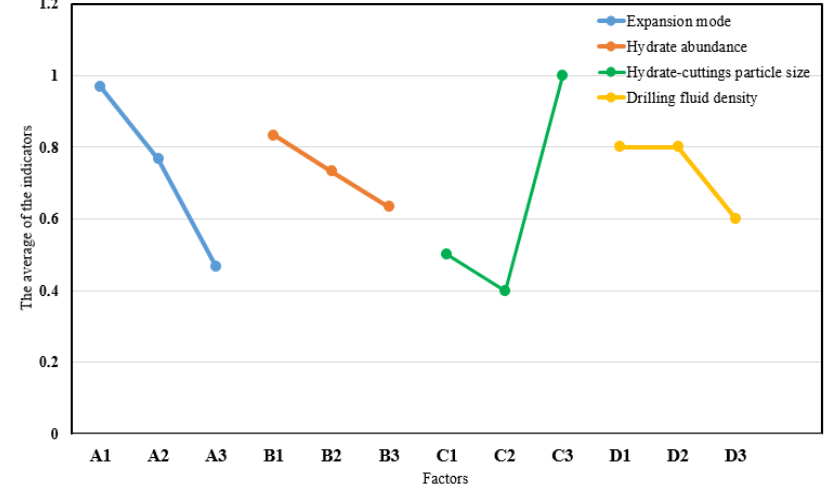
Figure 13. Trend chart of the influence of various factors on the critical velocity.